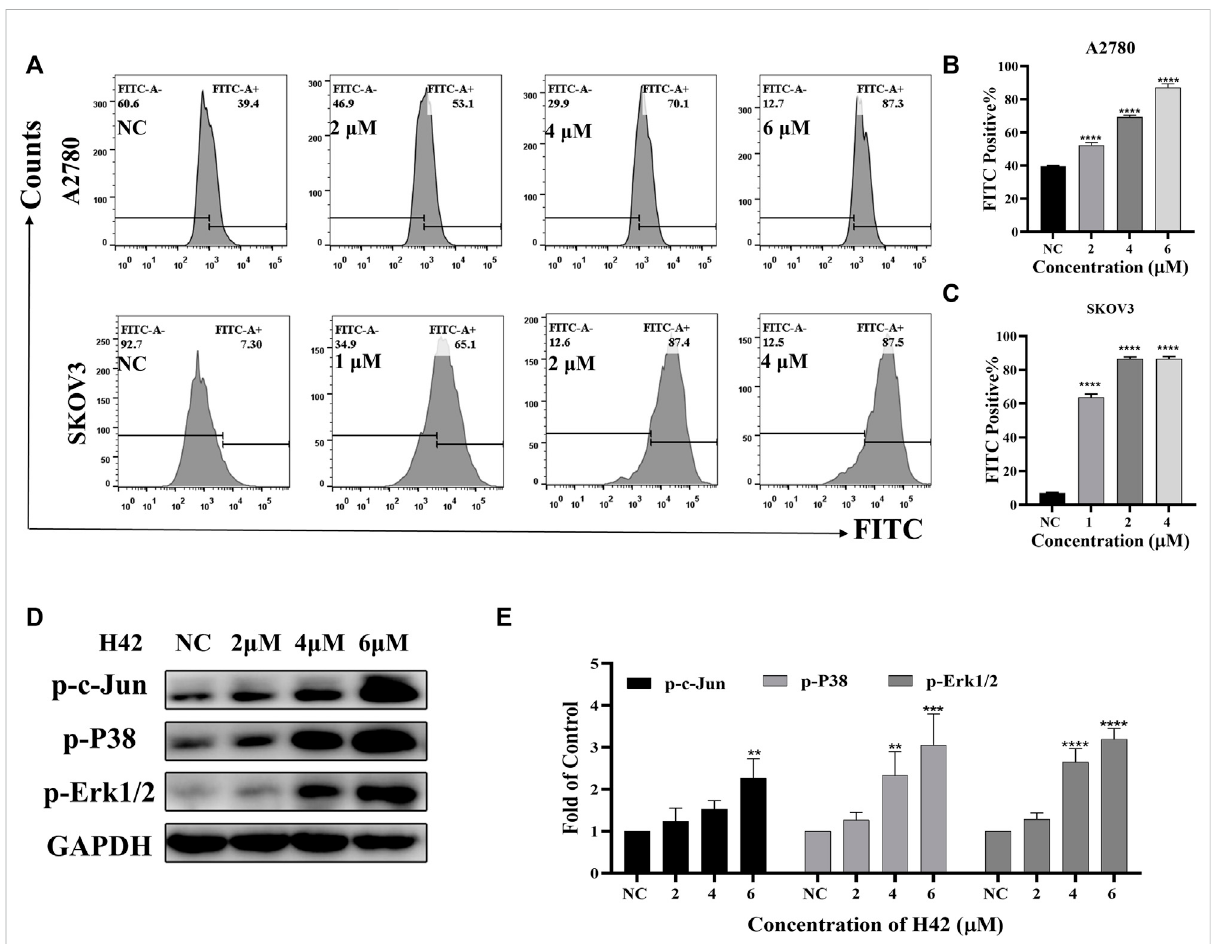
Compound H42 triggered cellular ROS generation in ovarian cancer cells. A2780 and SKOV3 cells were treated with various concentrations of H42 for 48 H. (A) Cellular ROS was detected by the DCFH-DA probe using FCM. Quantitative analysis of ROS generation is shown in (B,C) . (D) Expression of ROS-related proteins in A2780 cells was examined by Western blot and (E) analyzed in the density ratio. Data are all represented as mean ± SD of at least three independent experiments. ** p < 0.01, *** p < 0.001, and **** p < 0.0001 were compared with the